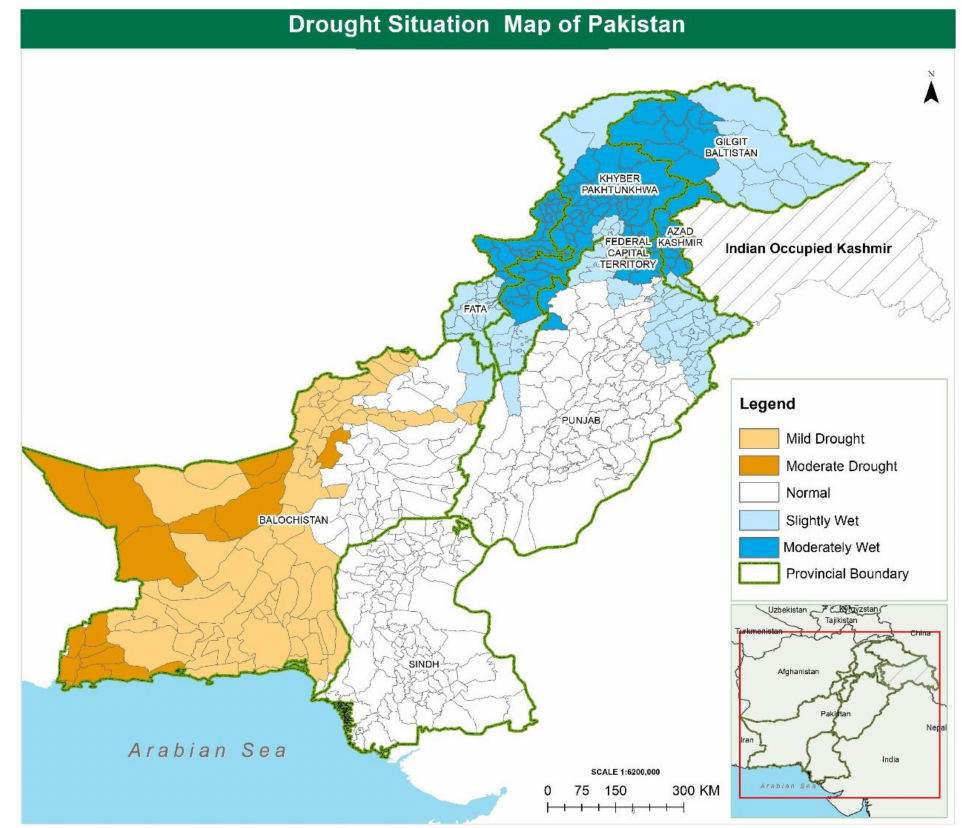
Figure 8. Illustration of the situation of droughts in all Pakistani